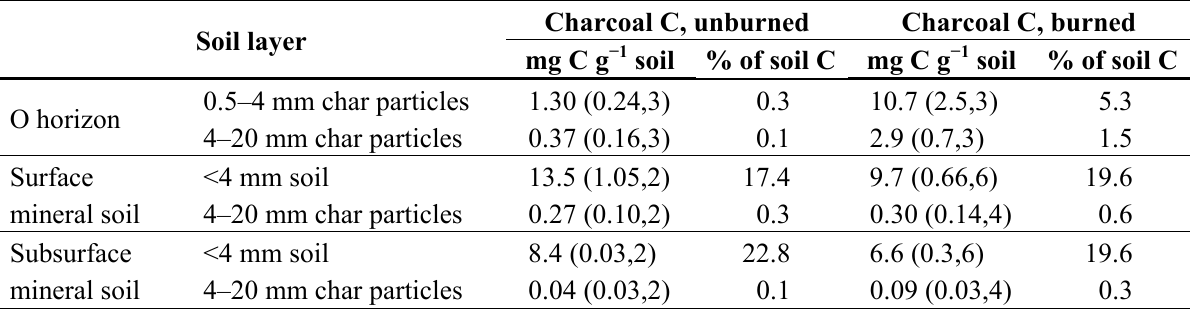
Table 1. Charcoal C [mean (standard error, n experimental units)] in soils from Siskiyou-Long-Term Ecosystem Productivity (LTEP) experimental units with recent history of being unburned or